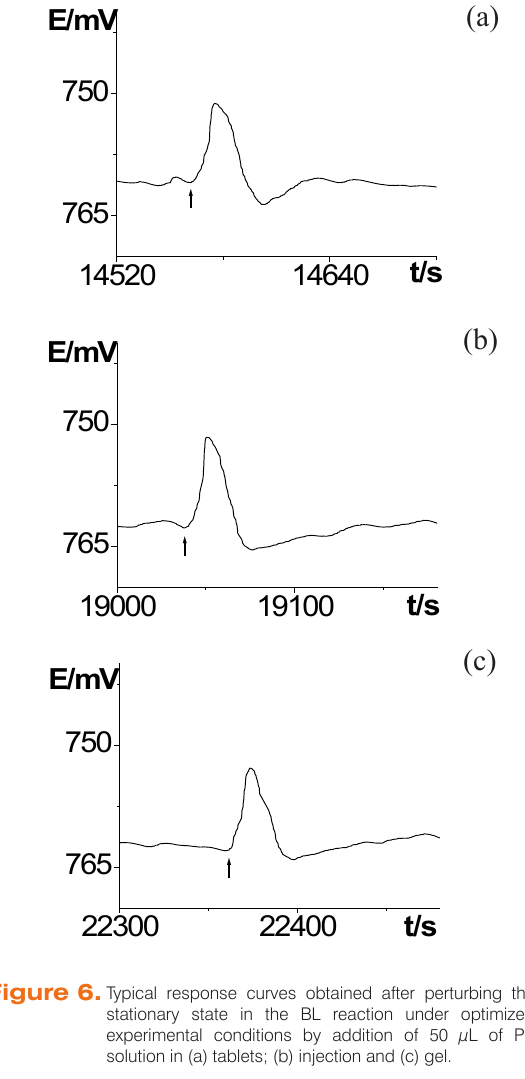
Table 4. Determination of PX in pharmaceutical preparations.